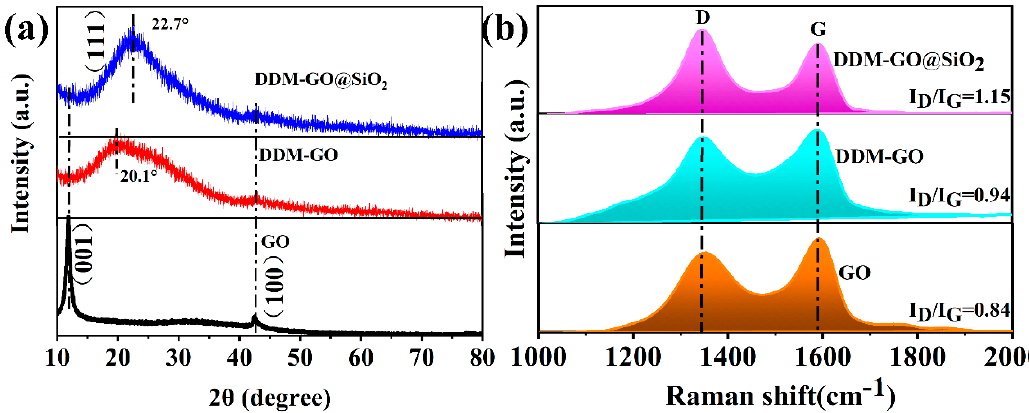
Figure 3. ( a ) XRD spectra of GO, DDM − GO, DDM − GO@SiO 2 , ( b ) Raman spectra GO, DDM − GO, DDM − GO@SiO 2. Raman spectra of GO, DDM − GO, and DDM − GO@SiO 2 show two distinctive